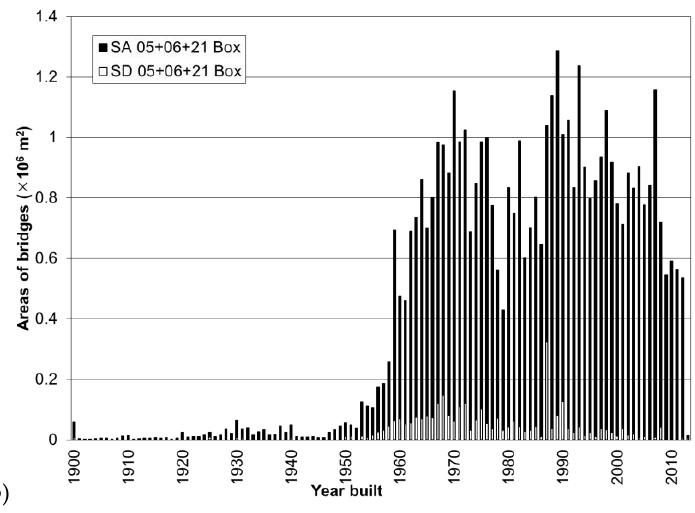
Figure 3. Distribution and SA to SD ratio of box (types 05, 06 and 21) bridges. (a) Counts and (b) Areas.